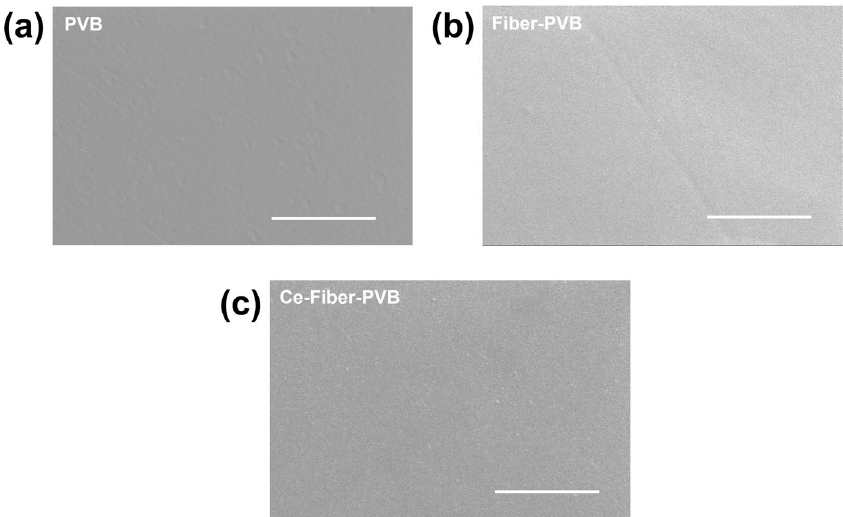
Fig. 3 Characterization of coating samples by SEM. Surface morphologies of AA2024-T3 dip-coated with a PVB, b Fiber-PVB, c Ce-Fiber-PVB examined by SEM. Scale bar is 50 µm. The thicknesses of PVB, Fiber-PVB, and Ce-Fiber-PVB were 14, 17, and 16 µm, respectively.